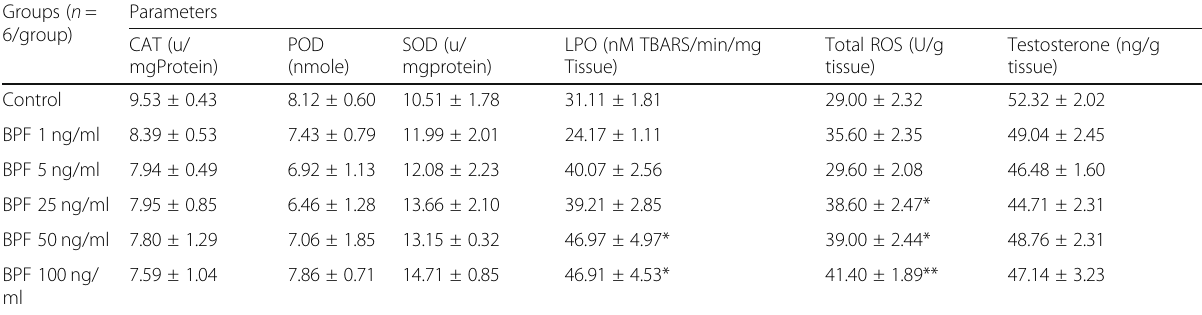
Table 1 In vitro effect of Bisphenol F (BPF) on antioxidant enzymes and testosterone secretion in rat testis Groups ( n =